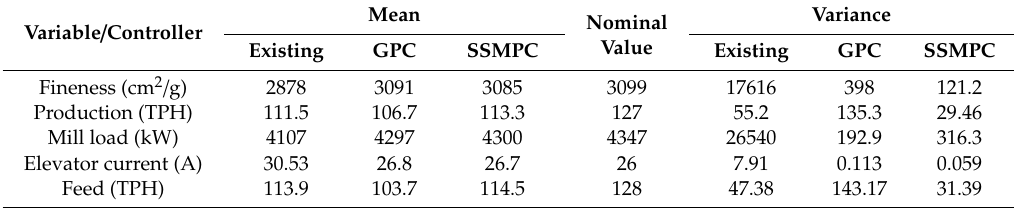
Table 5. Mean and variance of process variables by implementing di ff erent controllers in the closed